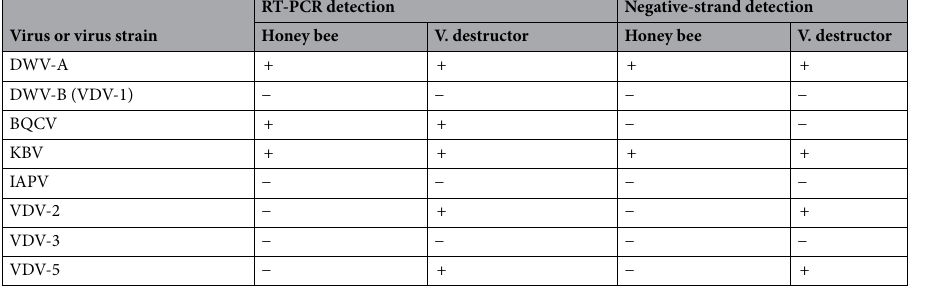
Table 2. RT-PCR and replication assay results for viruses in honey bees and V. destructor . Pooled V. destructor and honey bee samples were screened for eight viruses (DWV-A, DWV-B (VDV-1), BQCV, KBV, IAPV, VDV-2, VDV-3 and VDV-5). Positive test results are indicated with ( +) while (−) indicates that no band was observed. A positive result for the negative-strand detection assay is indicative that the virus is parasitising the host cells. Primer pairs used in this analysis are shown in Supplementary Table